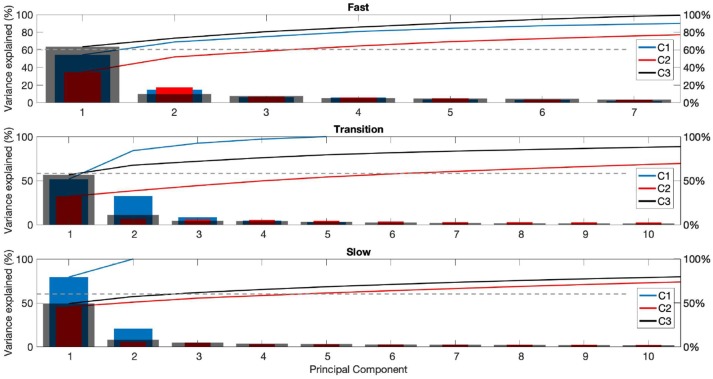
Principal component (PC) analysis results for participants C1-3 for the different playing phases: very fast (top left panel), fast (top right panel), transition (bottom left panel), and slow (bottom right panel). Each panel shows the percentage of variance accounted for by PCs 1-10 for players D1 (blue), D2 (red), and D3 (gray).